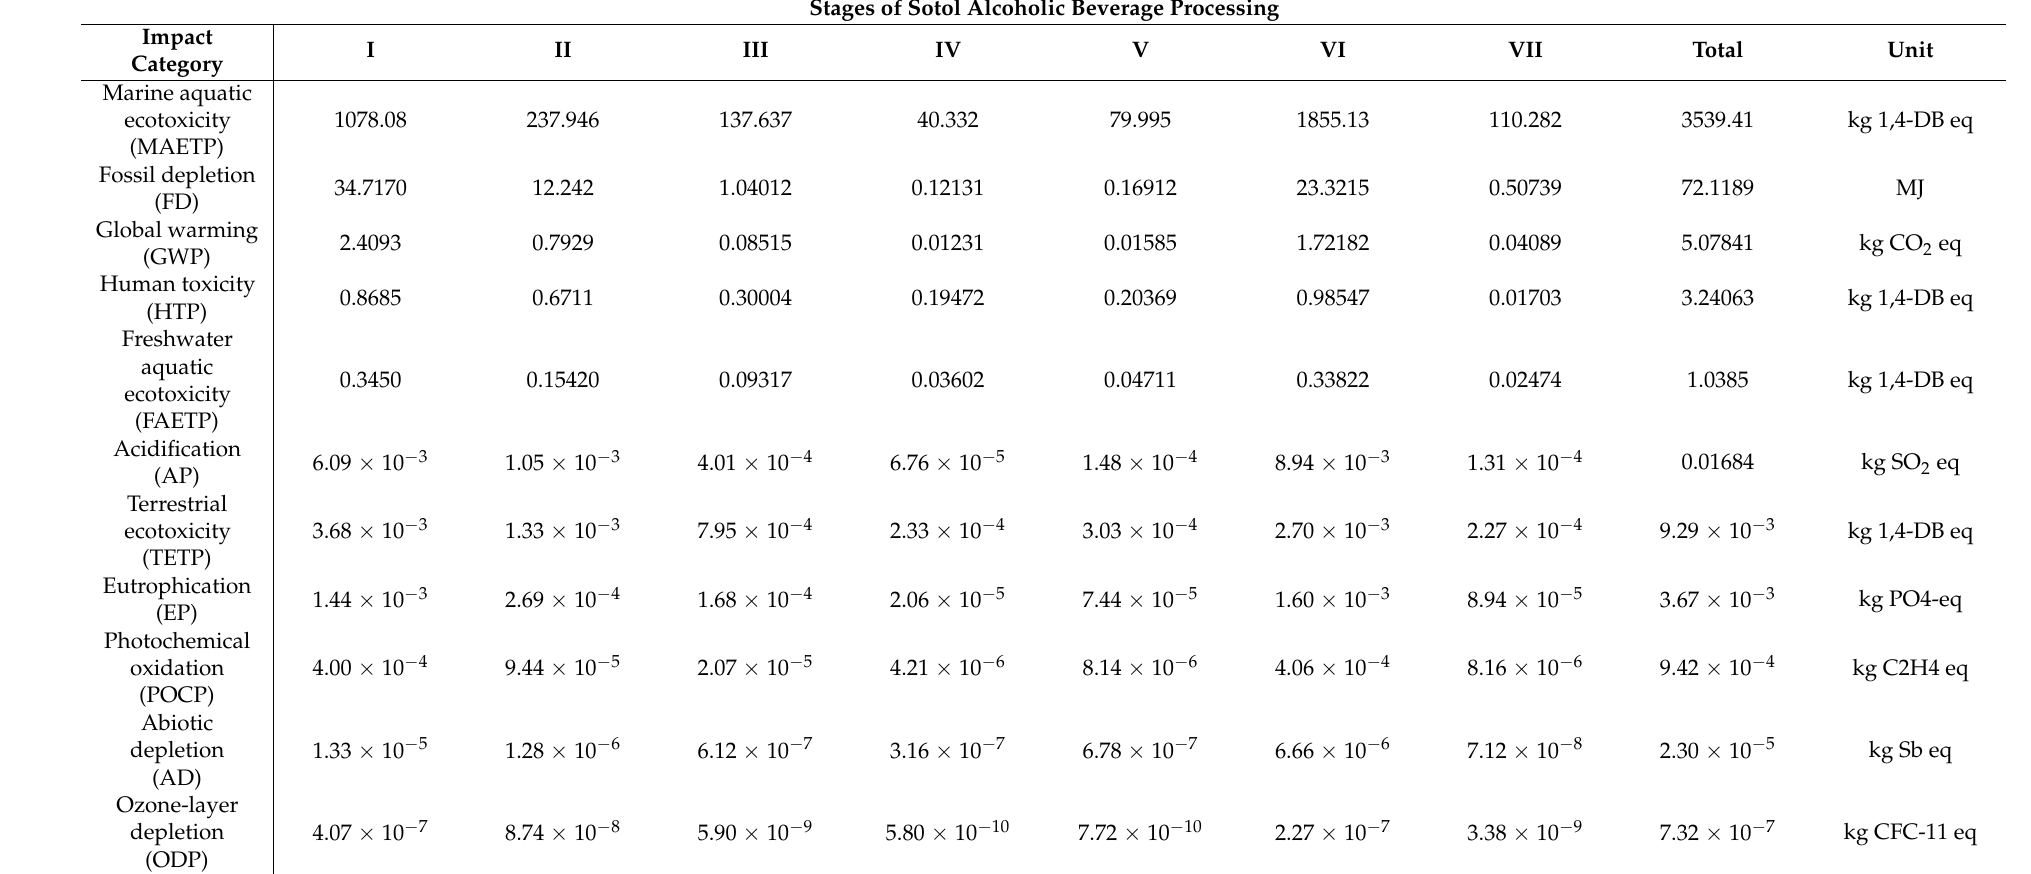
Table 2. Environmental impact categories of the sotol industrial production